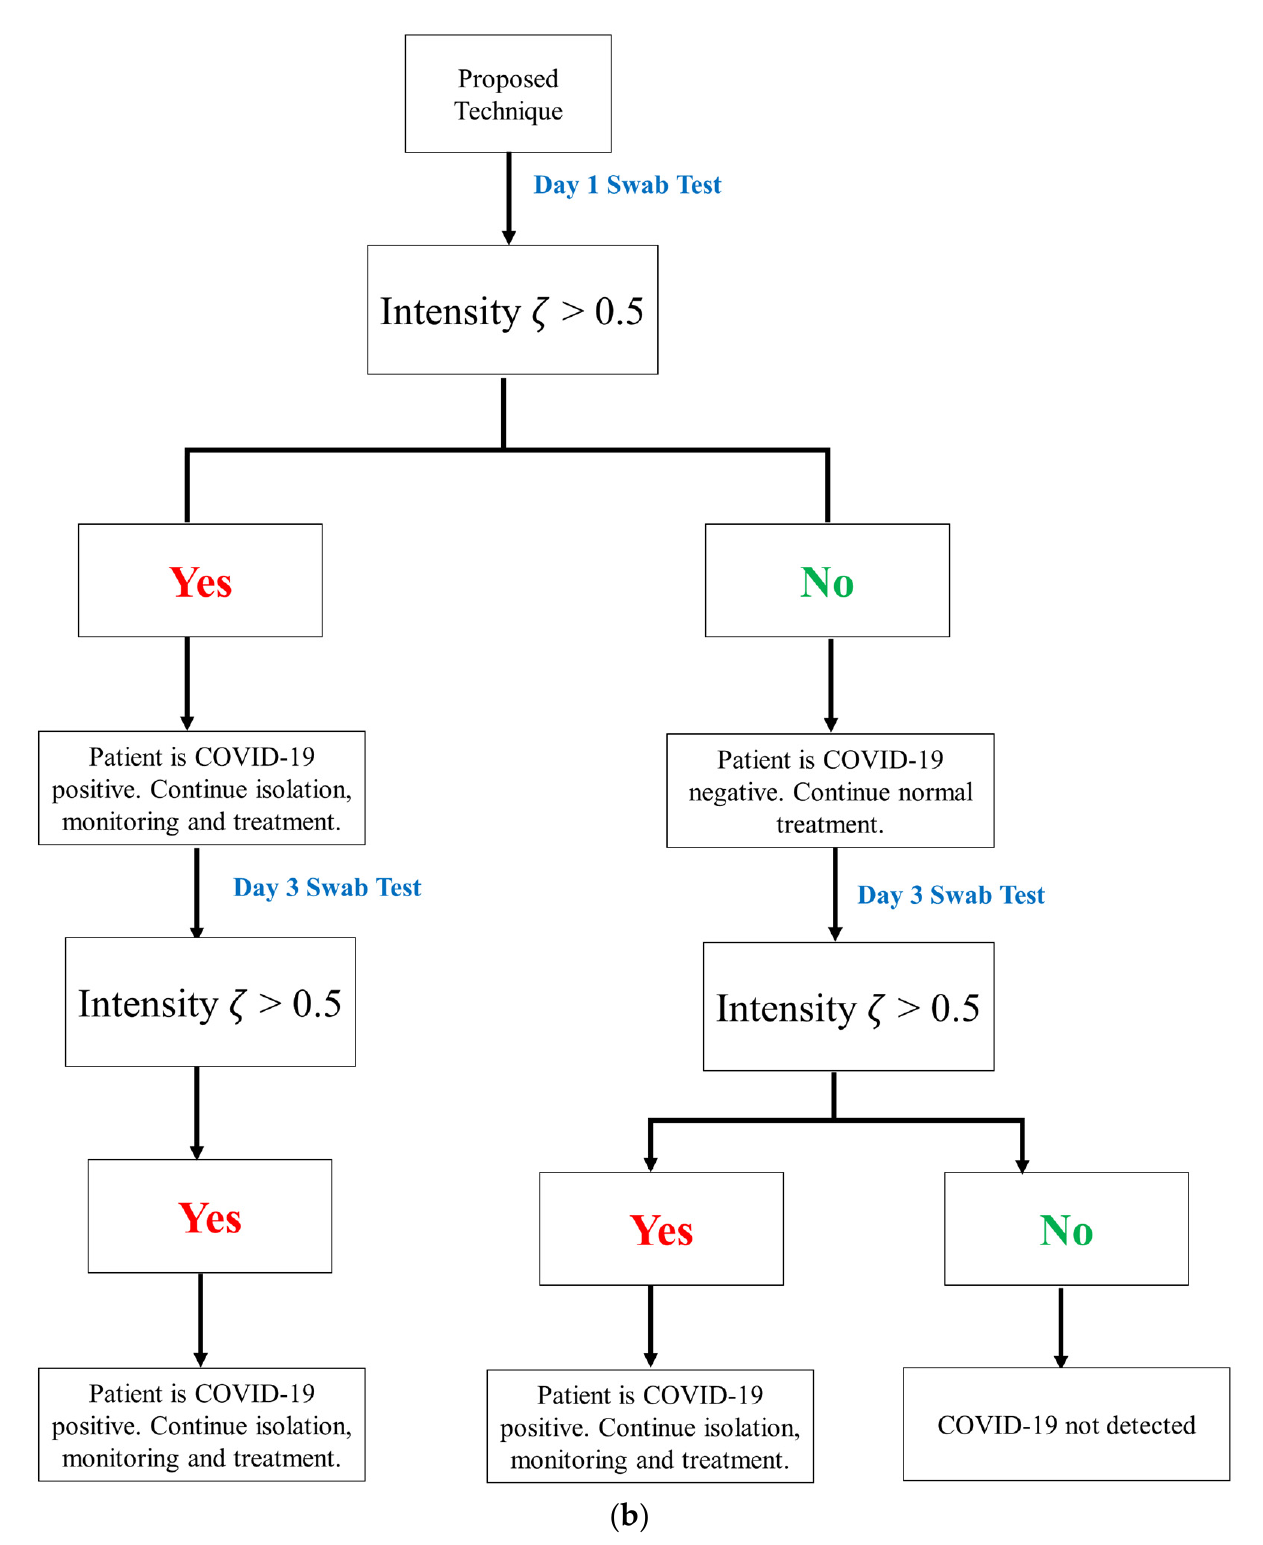
Figure 11. ( a ) Process flow of the conventional COVID-19 detection followed in the hospital under observation; ( b ) process flow of the proposed early detection of COVID-19.